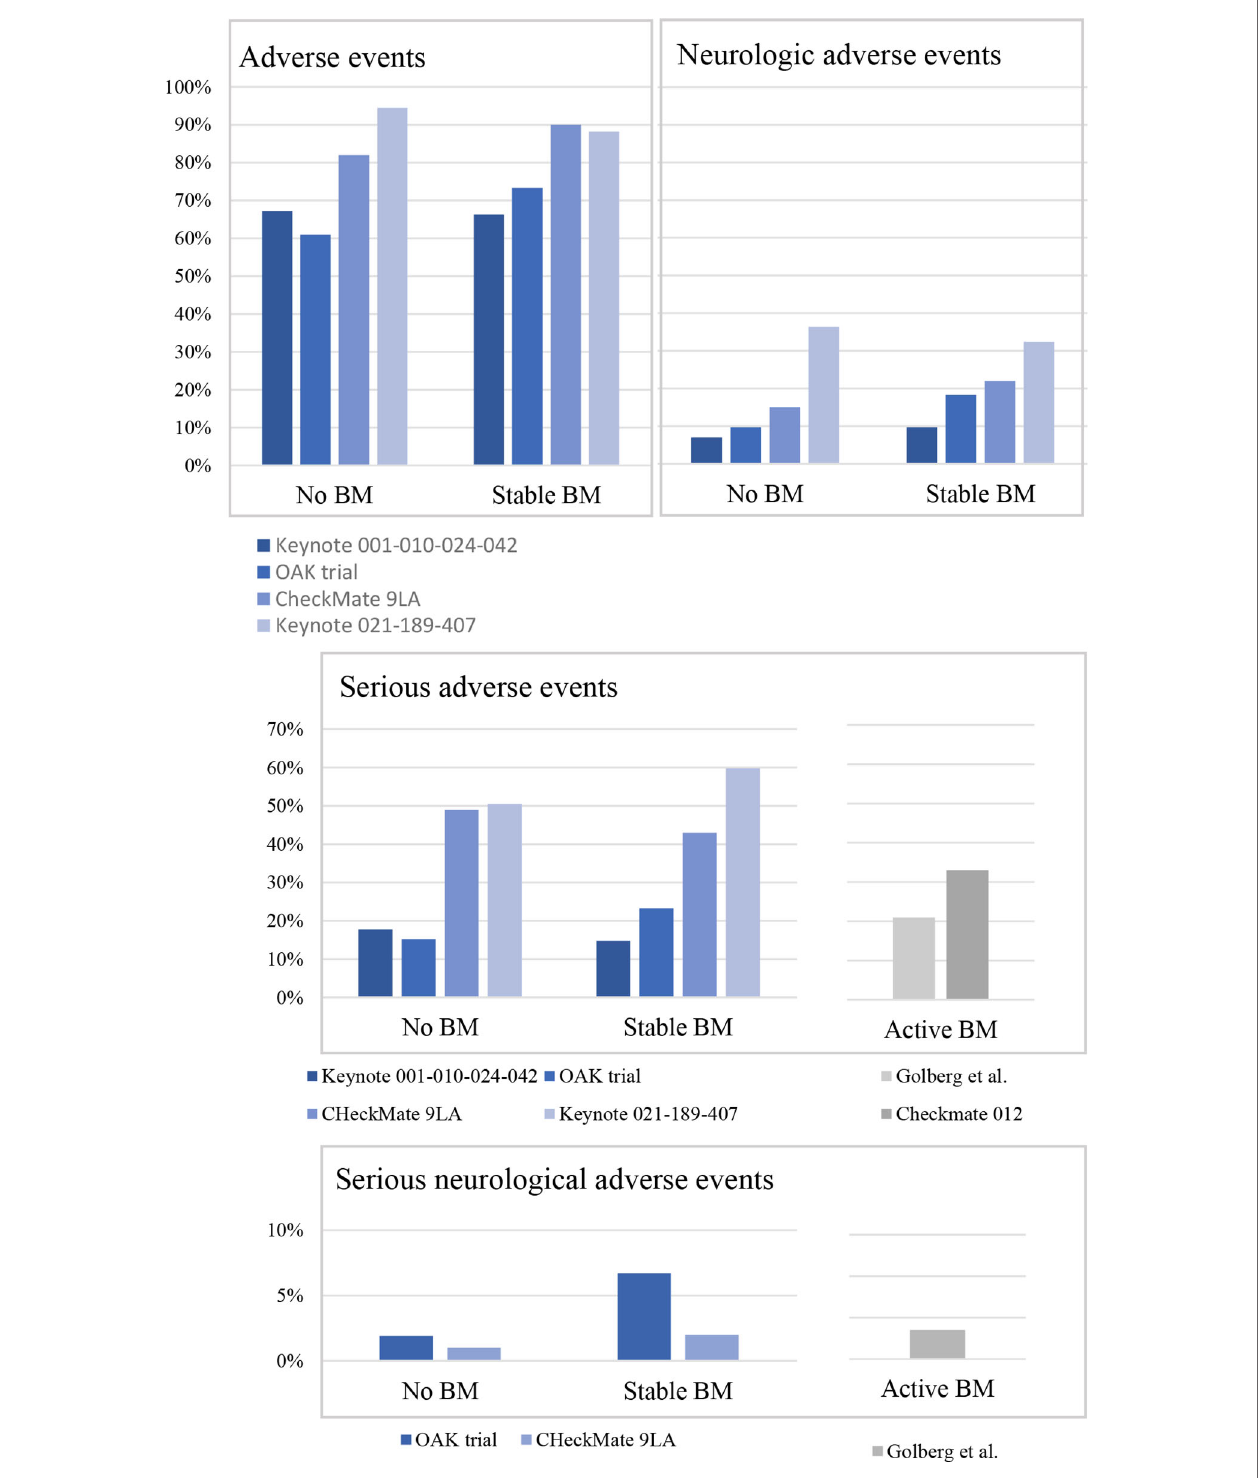
FIGURE 1 | Safety in non-small cell lung cancer patients treated with immunotherapy according to the intracranial involvement. BM, brain metastases; Keynote 001- 010-024-024, pembrolizumab arm only; Keynote 021-189-407, pembrolizumab plus chemotherapy only; OAK trial, atezolizumab only; CheckMate 9LA, nivolumab plus ipilimumab plus chemotherapy arm